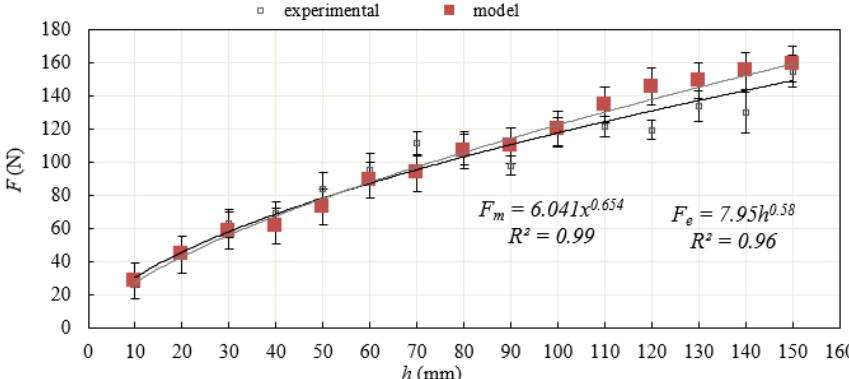
Figure 8. Influence of the drop height on the experimental and model force value, for wood type substrates. Fm —means model force, Fe —means experimental force. Error bars represent mean ± SD (standard deviation).